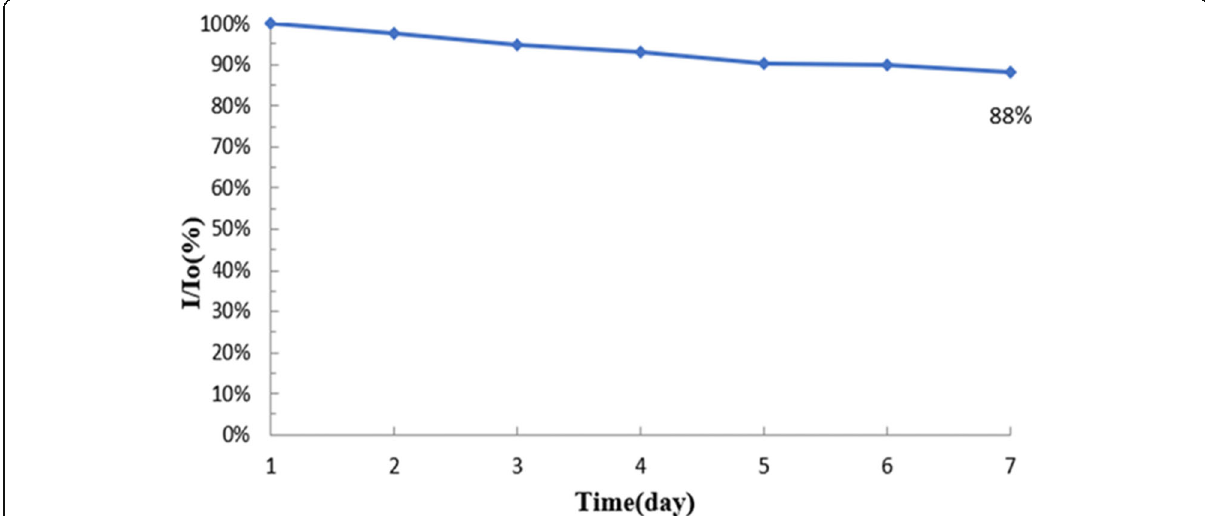
Fig. 11 Stability test chart placed at room temperature for 7 days on β -CD/SnS 2